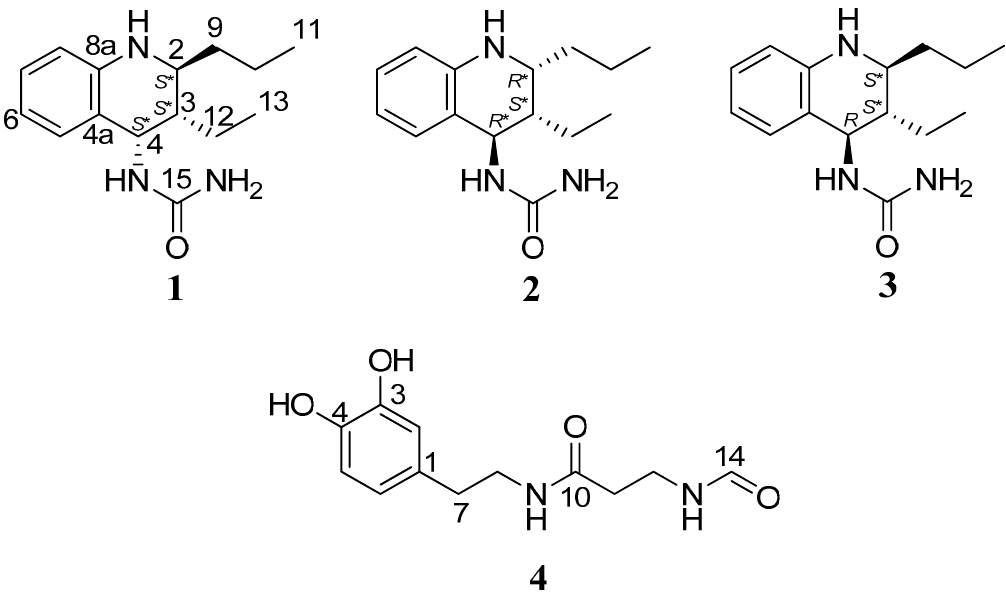
Figure 1. Chemical structures of tetrahydroquinolines (1–3) and a dopamine derivative (4).